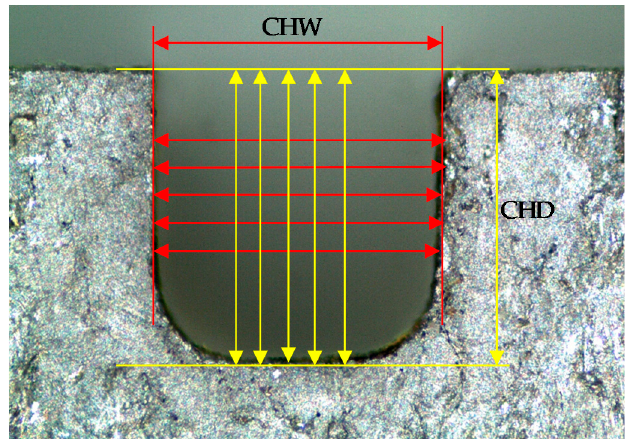
Figure 3. Microchannel dimensional measure (microchannel width (CHW) and depth (CHD)).